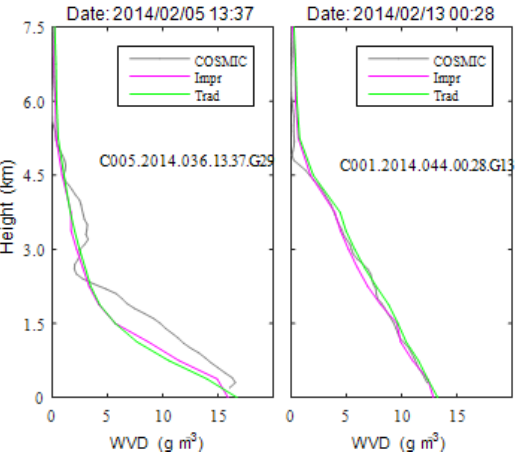
Figure 7. Comparisons of water vapor densities obtained from to- mography and COSMIC products on 5 and 13 February 2014. “COSMIC” represents the water vapor density derived from wet- Prf product. “Impr” represents the tomography-derived water va- por density using our optimized method, and “Trad” represents the tomography-derived water vapor density using the traditional